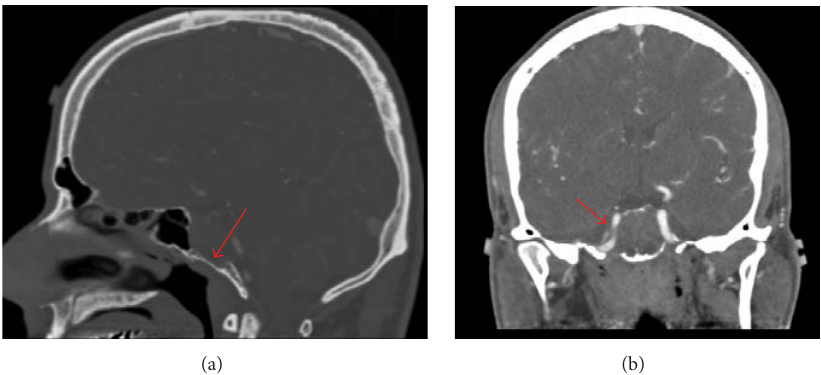
Figure 1: Preoperative computed tomography angiogram (CTA) scan, sagittal bone window (a) and coronal vascular window (b) sections, showing poorly vascularized clival mass that erodes the clivus (a) and encases the right internal carotid artery (b).